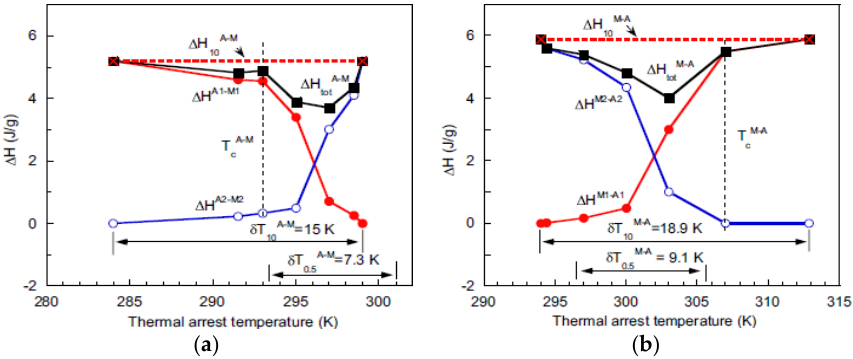
Figure 16. Absolute values of latent heat determined by interrupted measurement at different stages during: ( a ) forward and; ( b ) reverse L2 1 ‐ orthorhombic martensitic transformation in Ni 43 Co 7 Mn 39 In 11